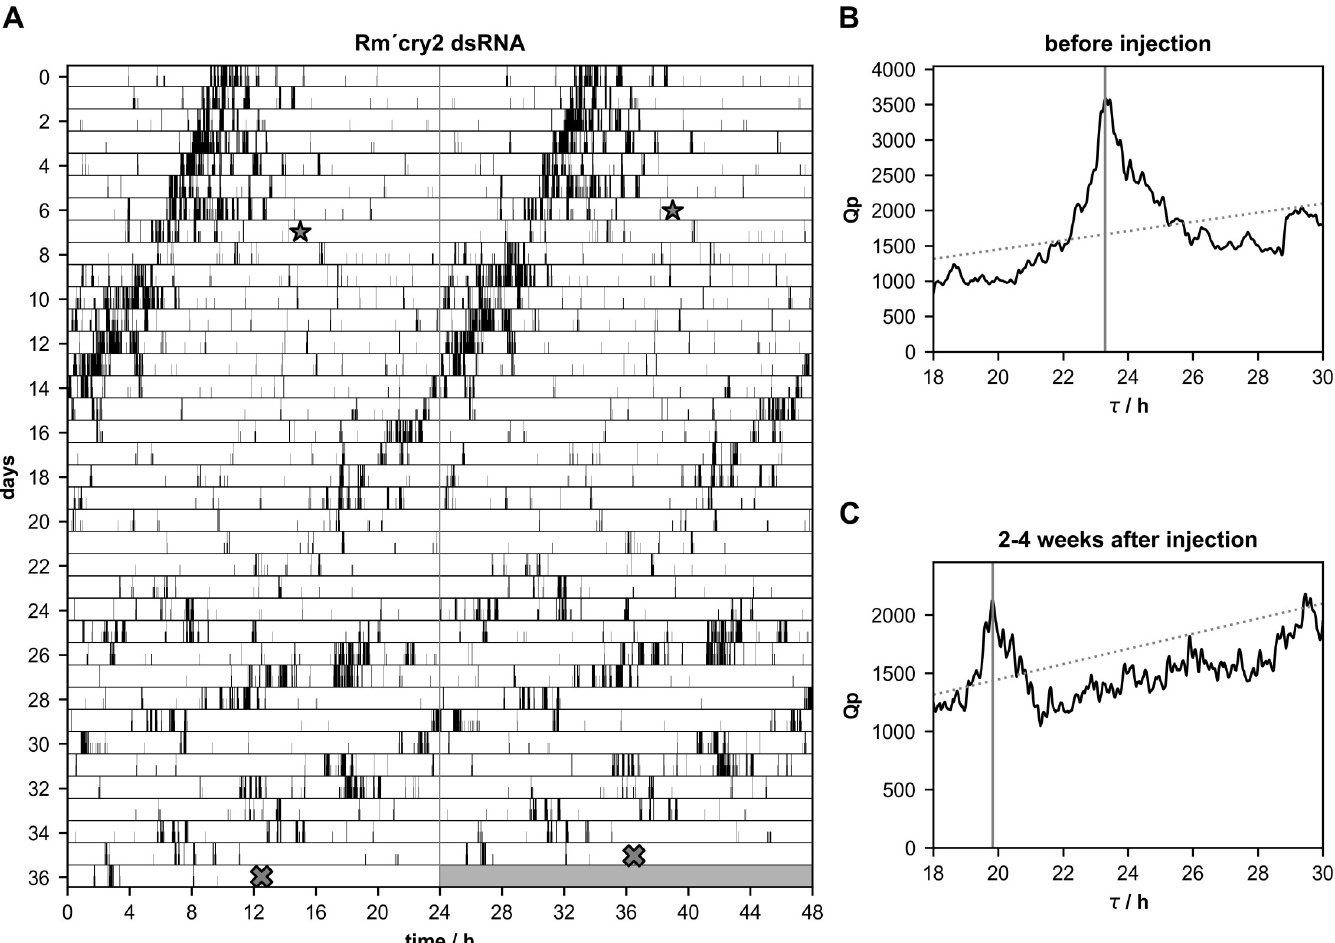
Fig 6. A-C. Injections of Rm´cry2 dsRNA significantly shortened the free-running period( τ )of locomotor activity rhythms (n = 14 of 20; p < 0.0001). (A) Double-plotted running wheel activity of a Madeira cockroach in constant darkness revealed significant shortening in the period of its locomotor activity rhythm after injection of Rm ´cry2 dsRNA at day 7 (star) of the recording. At day 36 of the locomotor activity recording the cockroach was sacrificed (cross) and qPCR was used to confirm the knockdown. Chi-square periodogram analysis of the activity 1–7 days before dsRNA injection revealed a period of 23.30 h (B) , and 2–4 weeks after the injection of 19.83 h (C) .